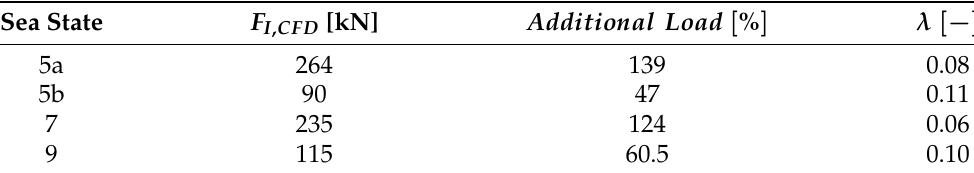
Table 7. The slamming force ( F I , CFD ) as calculated from the CFD simulations, the percentage contribution of slamming force ( AdditionalLoad ) in the total inline force, and the factor λ identifying the impact area on the